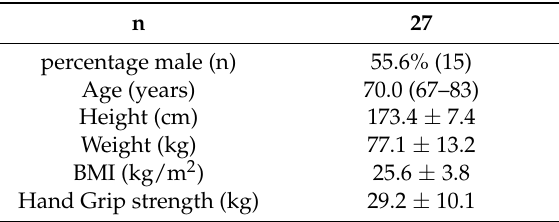
Table 1. Descriptive statistics of study